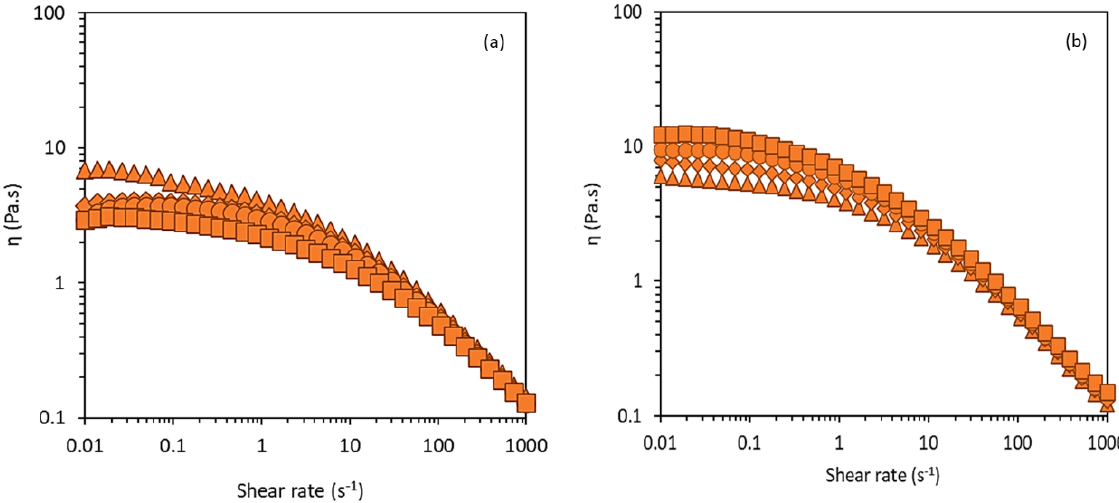
Figure 2. Flow curves for the FucoPol-based emulsions (analysed after 24 h of preparation) with ( a ) Olea europaea fruit oil and ( b ) Prunus amygdalus dulcis oil, supplemented with L-ascorbic acid at concentrations of: 5.0 wt.% (triangles), 8.0 wt.% (diamonds), 10 wt.% (circles), and 15 wt.% (squares).